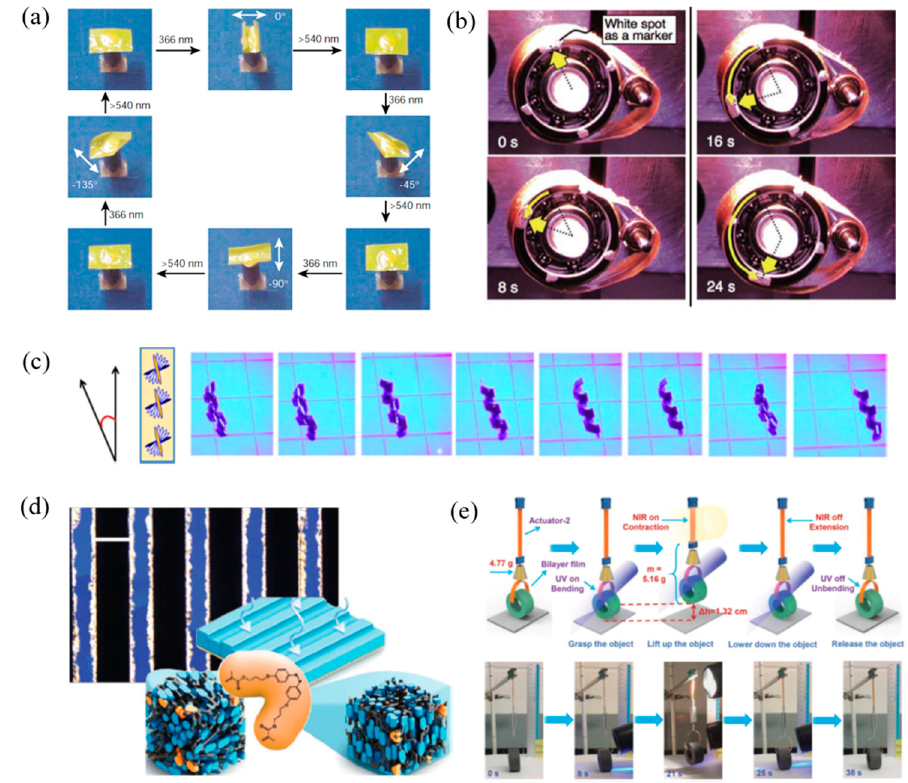
Figure 6. Photo responsive LCPs based on trans–cis photoisomerization of azobenzene irradiation by UV and visible light. ( a ) Precise control of the film bending and unbending in different directions in response to linearly polarized light. Reproduced with permission from [72]. Copyright 2003, Nature Publishing Group. ( b ) The rotation of the LCP laminated plastic motor driven by simultaneous irradiation with UV and visible light at room temperature. Reproduced with permission from [14].